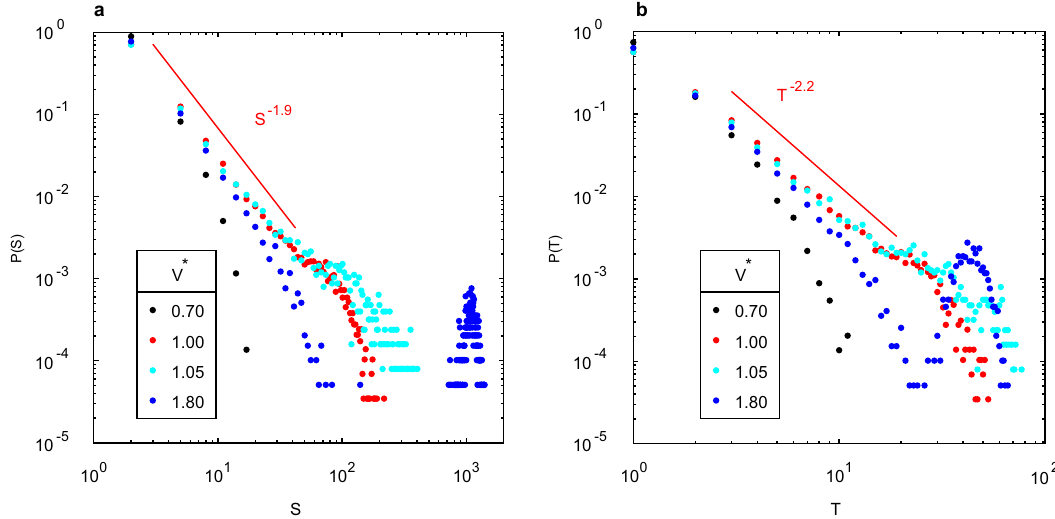
Fig. 5 Voltage dependence of avalanche simulations. Avalanche size S ( a ) and life-time T ( b ) distributions in simulated NWNs at voltages V * = 0.7, 1.0, 1.05, 1.8 (black, red, cyan, blue). Statistics are produced from simulations on an ensemble of 1000 independently generated networks with 1000 nanowires and 3000 – 3200 junctions (size 100 × 100 μ m 2 and density 0.10 nw ( μ m) − 2 ). The time-frame ( Δ t = 160 ms, corresponding to average inter-event-interval at V * = 1) chosen to bin switching events is the same for each V * and distributions are linearly binned with same bin-sizes for each